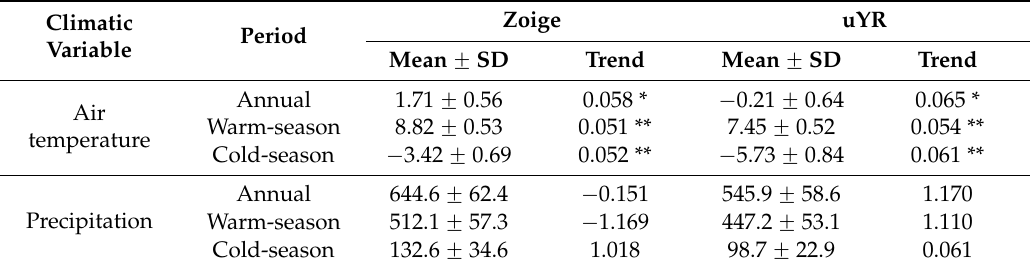
Table 3. Climate trends of the Zoige Basin and the uYR basin from 1985 to 2007 represented by weather station observations (Ta, air temperature, ˝ C; Ta trend: ˝ C ¨ year ´ 1 ; precipitation trend: mm ¨ year ´ 1 ).